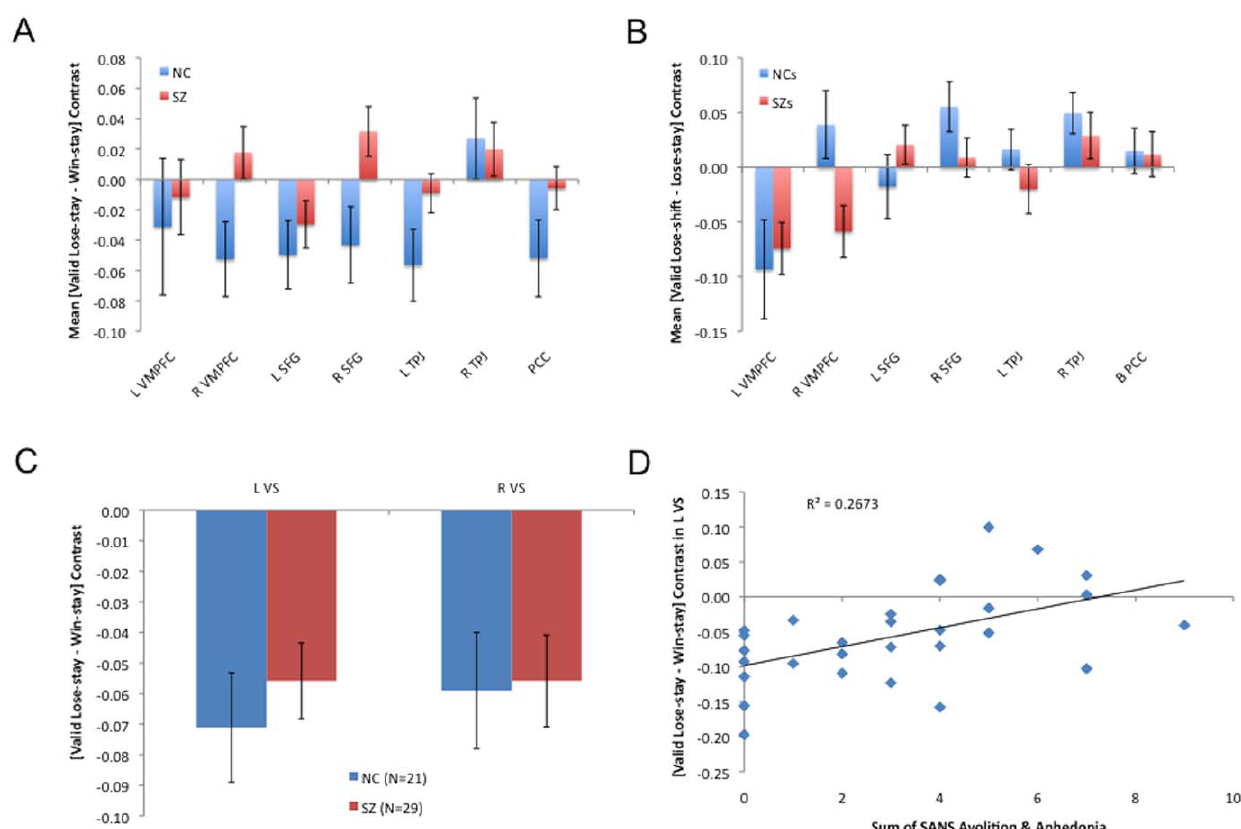
Figure 5. Responses in patients and controls in ROIs in default mode and reward networks. ( A ) Responses to lose-stays (relative to win- stays) in default network nodes. Patients showed reduced BOLD signal contrasts between valid lose-stays and valid win-stays in two components of default networks in frontal cortex. ( B ) Responses to lose-shifts (relative to lose-stays) in default network nodes in default network nodes. Patients showed deactivations for lose-shifts, relative to lose-stays in right mPFC, whereas controls showed the opposite pattern. ( C ) Responses to negative feedback (relative to positive feedback) in left and right ventral striatum ( 6 10, 8, 2 4). Both patients and controls strongly deactivated left and right VS for lose-stays, relative to win-stays. ( D ) Deactivation of left VS, in SZ patients, in response to lose-stays (relative to win-stays) correlated significantly with clinical ratings of avolition/anhedonia.